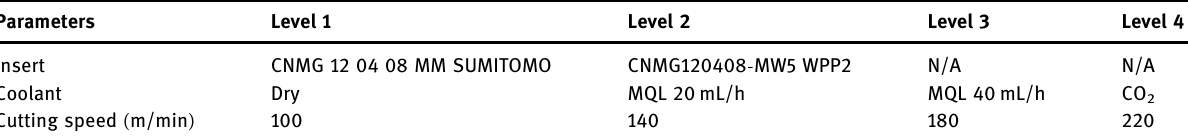
Table 2: Factors and grades in Taguchi experimental design